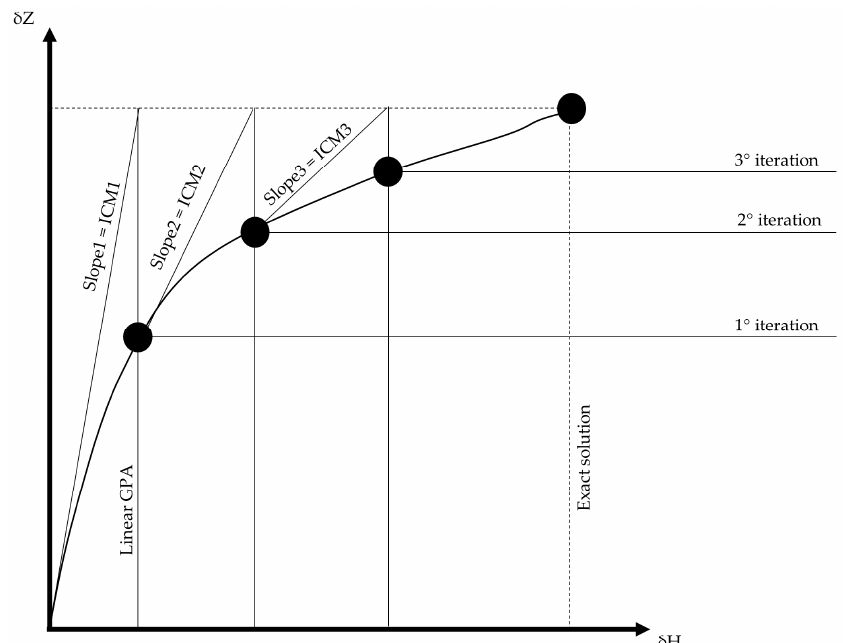
Figure 11 . Iterative process of the NLGPA algorithms [39]. Figure 11. Iterative process of the NLGPA algorithms